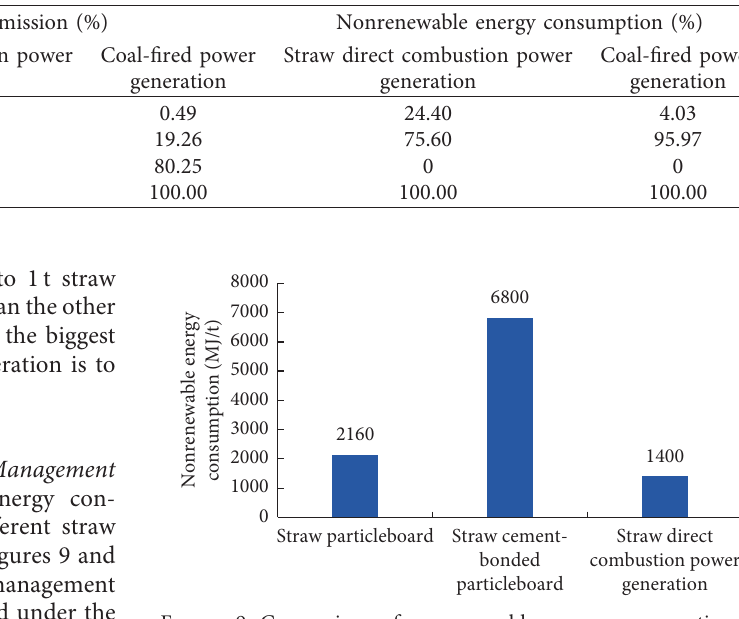
Table 11: Comparative contribution analysis for different electric power generation processes.